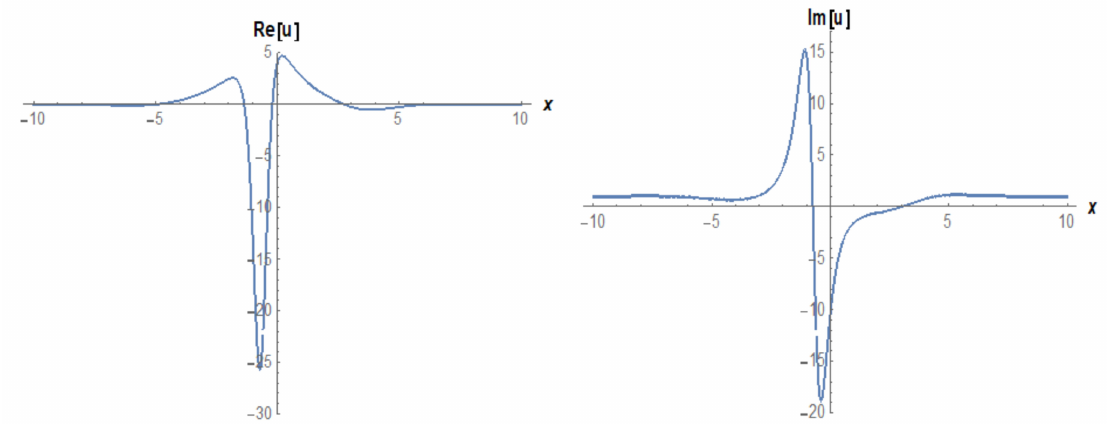
Figure 7. The 2D surfaces of Equation (20) under the values of ε = 0.4, t = 0.5, − 10 < x <